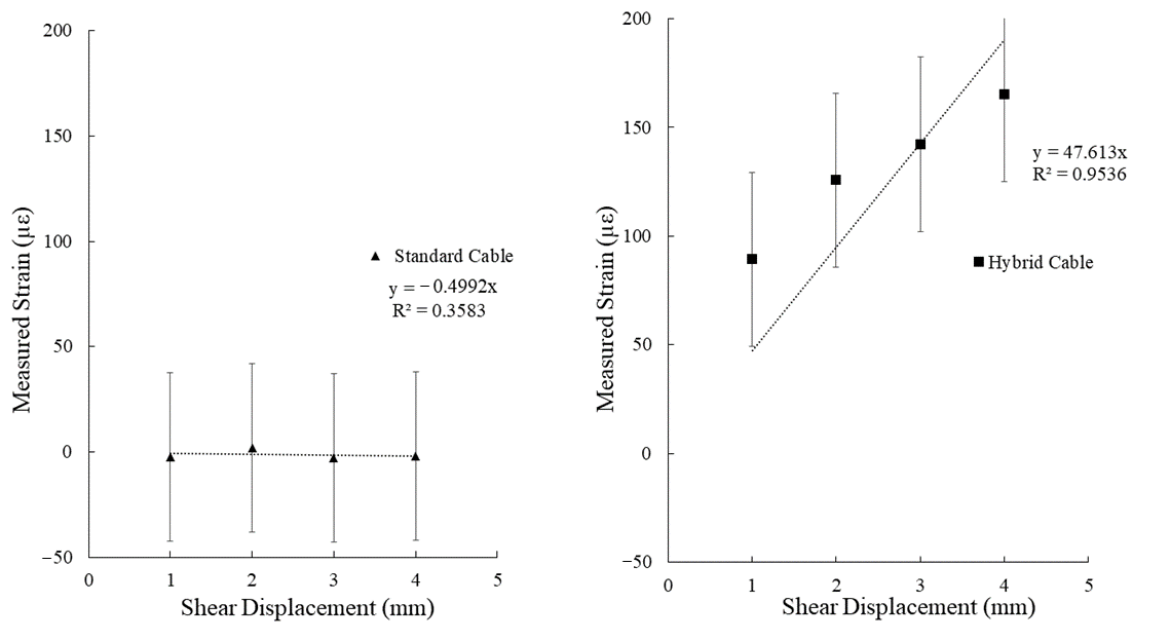
Figure 19. Measured strain verses applied axial displacement for a standard optical fiber cable ( left ) and the developed hybrid fiber optic cable ( right ).